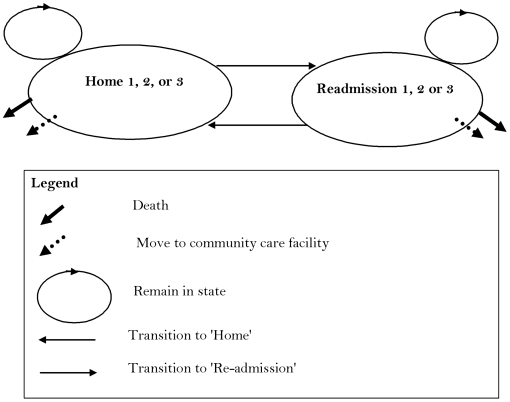
State transition Markov model.